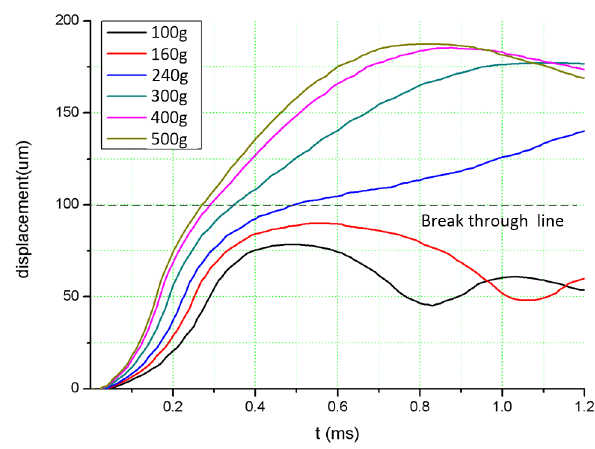
Figure 4. The simulation displacement-time curve of the switch.